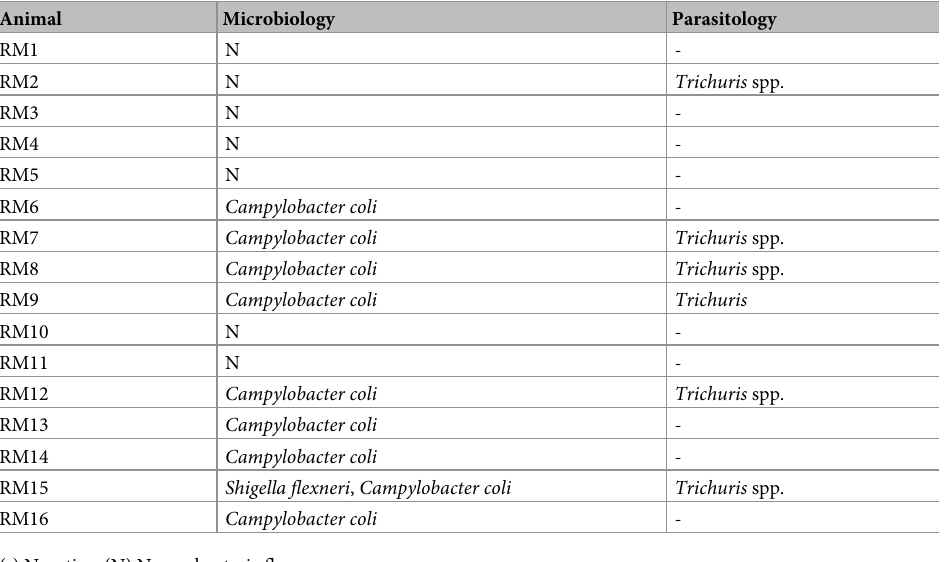
Table 2. Pre-treatment regimen fecal microbiology culture and parasitology examination results.